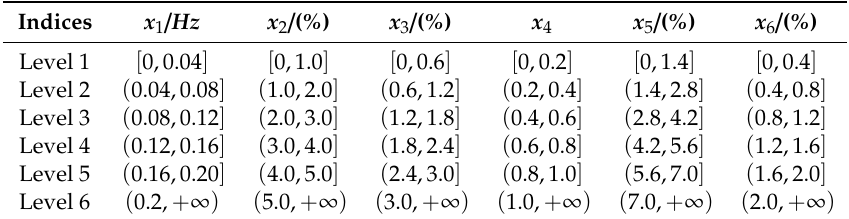
Table 2. Levels of power